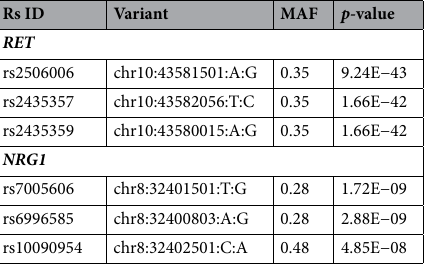
Table 1. Top variants that have strong marginal associations in RET and NRG1 . *rs2506006 is in high linkage disequilibrium with rs2435357 ( r 2 = 0.98). Variant column has the format of chromosomal position: alternative allele: reference